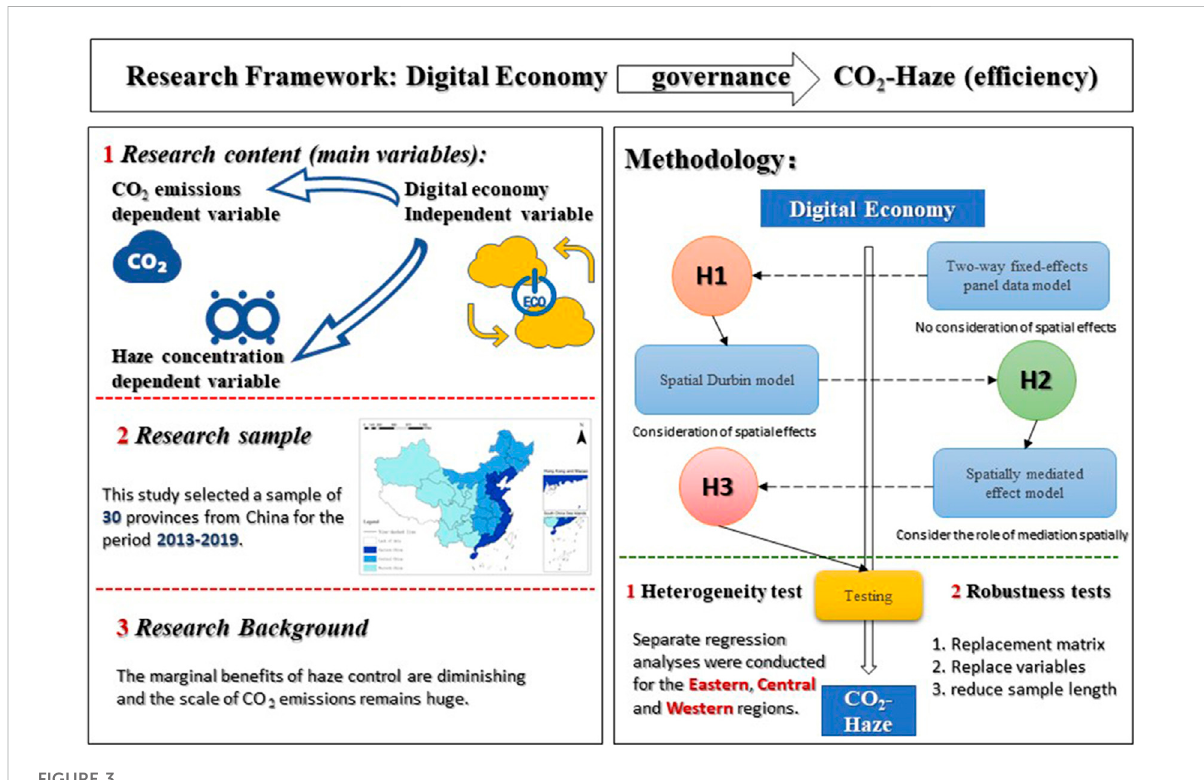
FIGURE 3 The digital economy and the synergistic management of